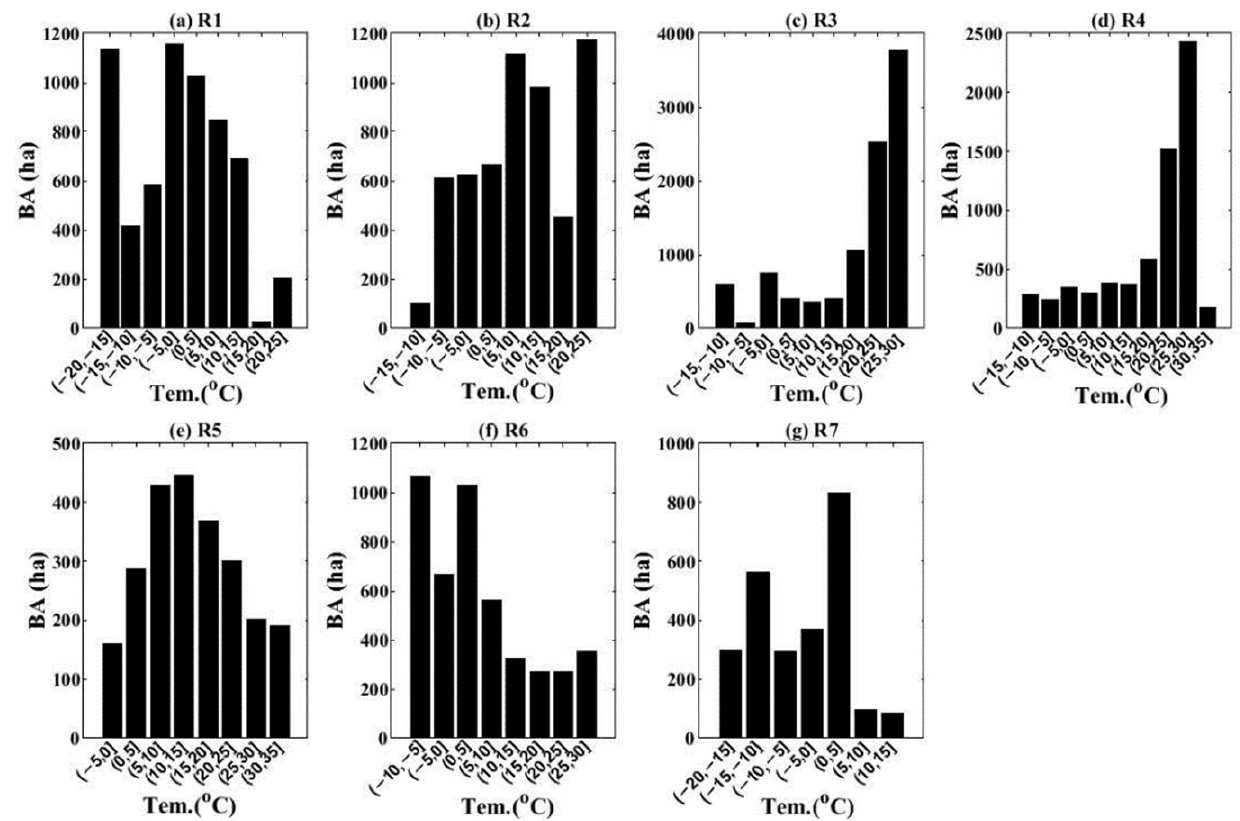
Figure 18. The histogram of BA with different temperature intervals for ( a – g ) representing R1–R7, respectively.